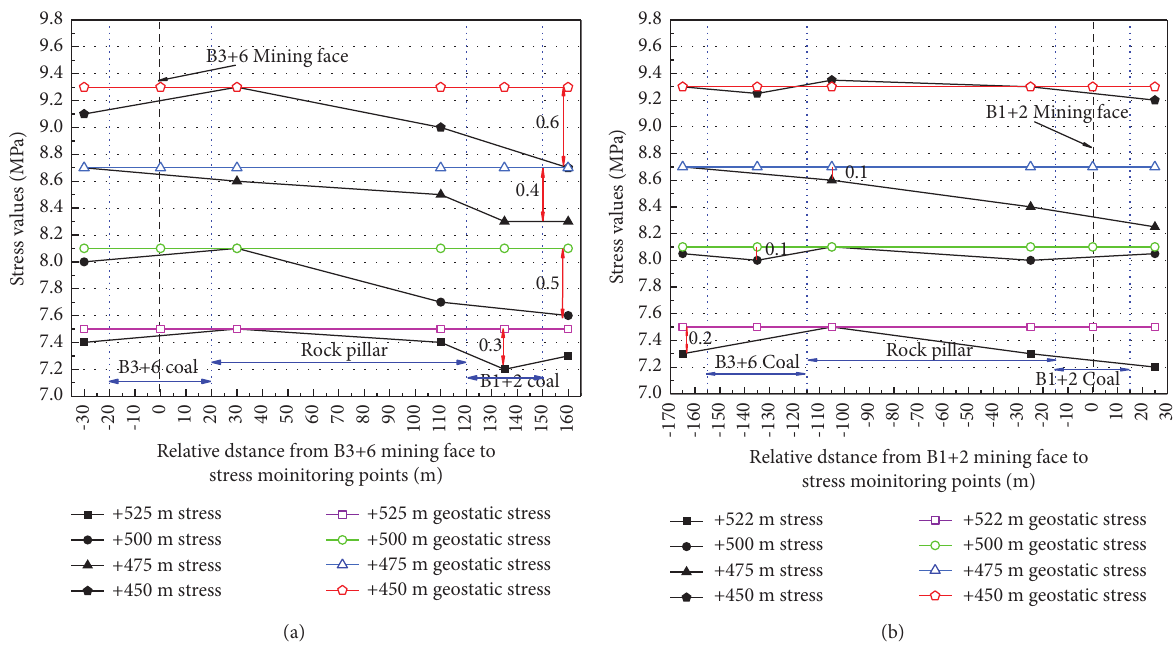
Figure 7: The stress distribution of overburden strata at different levels. (a) The stress distribution of the B3+6 coal seam after mining. (b) The stress distribution of the B1+2 coal seam after mining.